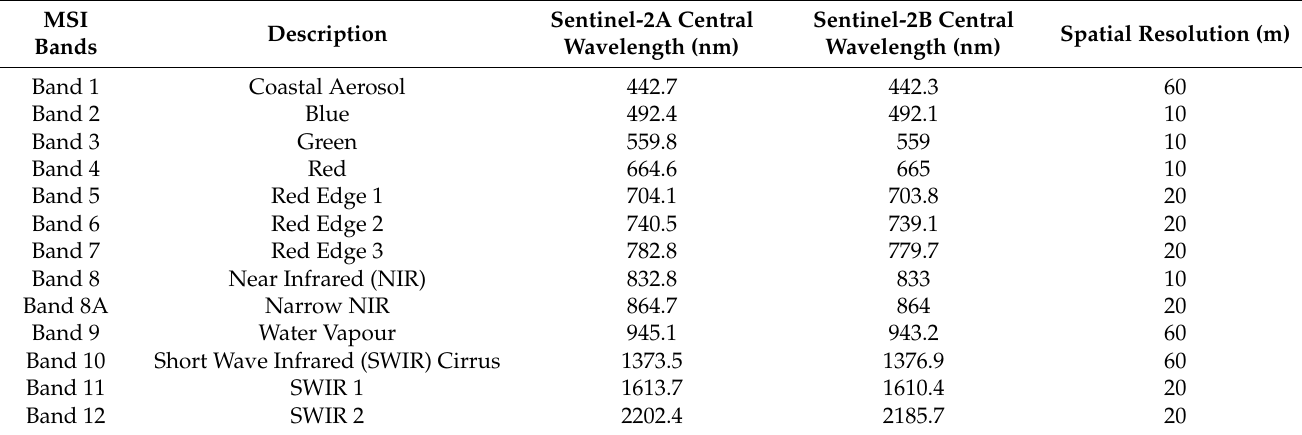
Table 1. Central wavelength value for Sentinel-2A and Sentinel-2B satellite multispectral instrument (MSI) bands. MSI